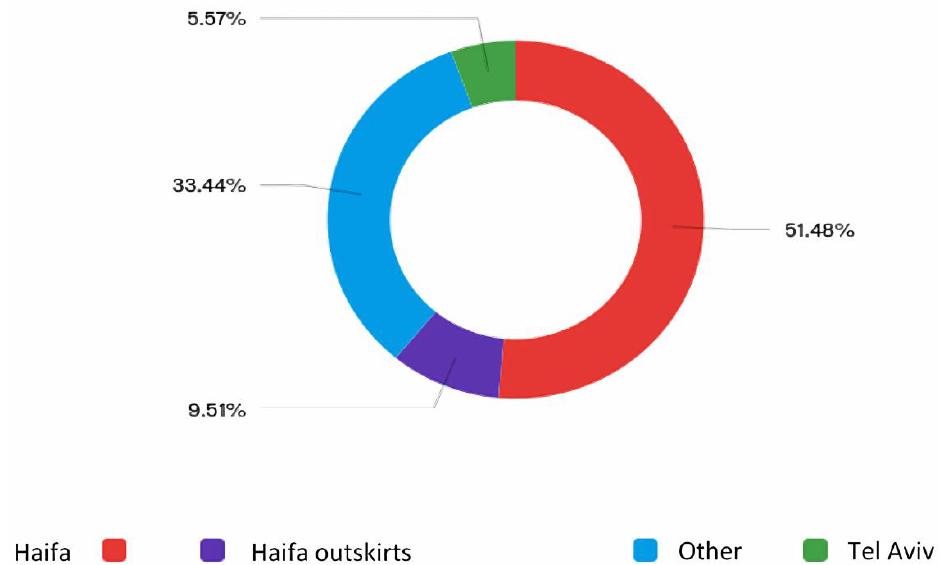
Figure 1. Geographical location of the sample in Israel.